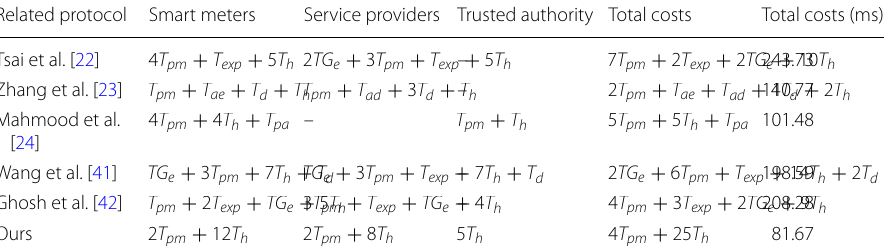
Table 3 Comparisons of the security features among different protocols Related protocol Smart